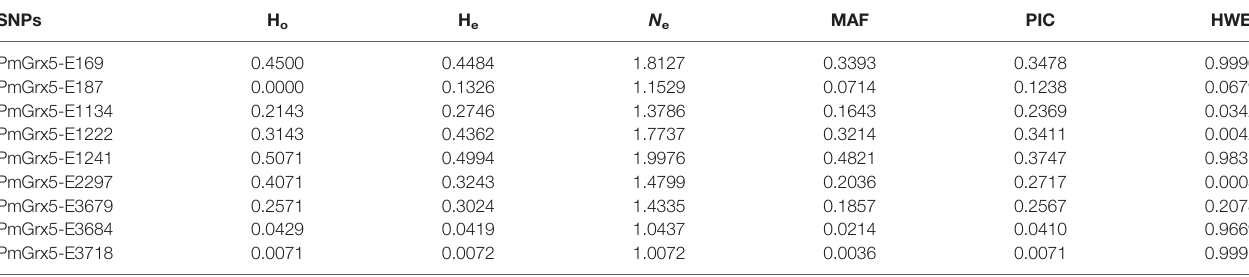
TABLE 3 | Polymorphic parameters of the SNPs of PmGrx5